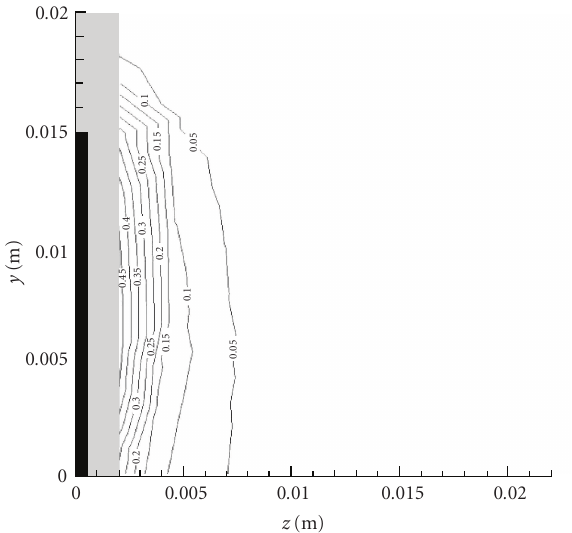
Figure 2: SAR pattern of the 3cm dipole. Because of symmetry, only half of the antenna is shown; the feedpoint at the center is the origin of the coordinate axes.